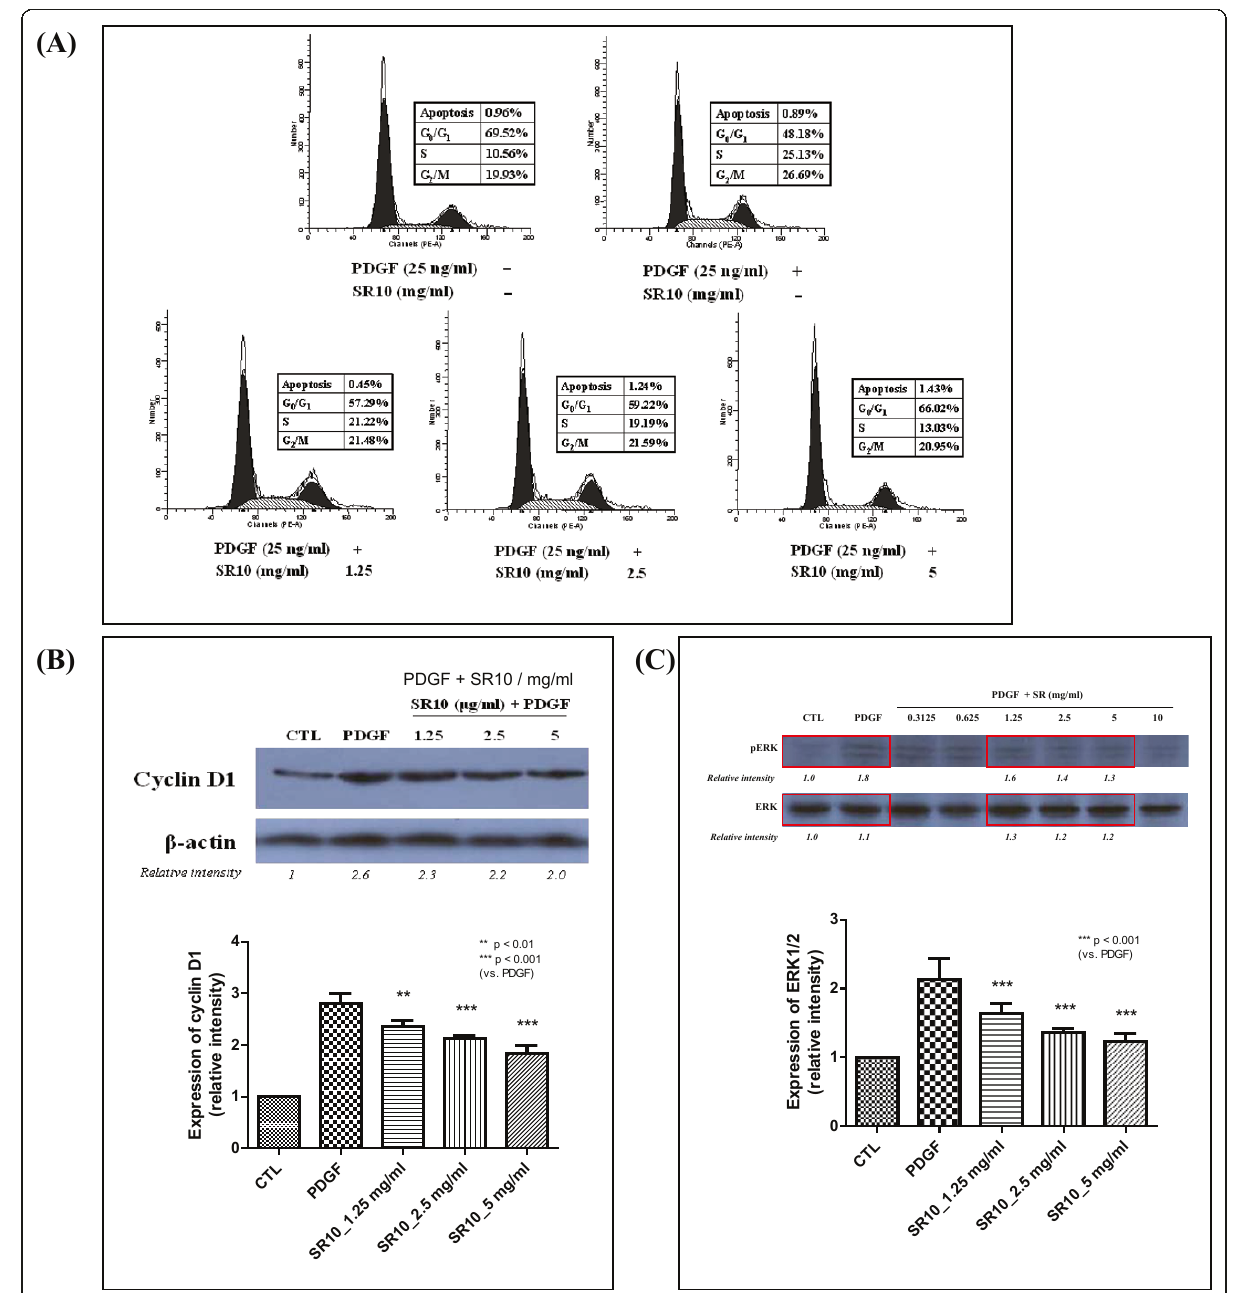
Figure 5 Effect of SR10 on cell cycle distribution of PDGF-BB-treated A7r5 cells . After starving with 1% fetal bovine serum for 24 hours, A7r5 cells were treated with PDGF-BB (25 ng/ml) in the absence or presence of SR10 for 24 hours. Then, the cells were stained with PI and cell cycle distribution was analyzed by flow cytometry. Three experiments were performed and similar results were observed. This figure showed the result of one representative experiment (A). The expression level of cyclin D1 was detected by Western blot. The figure is a representative of three independent experiments with similar results. The quantitation of cyclin D1 was performed by analyzing three sets of data by One-way ANOVA. Treatment of 1.25, 2.5 or 5 mg/ml of SR10 all suppressed the expression of cyclin D1 which was induced by PDGF. Statistical significance was indicated by ** p < 0.01 or *** p < 0.001 (B). The expression level of ERK1/2 was detected by Western blot. The figure is a representative of three independent experiments with similar results. The quantitation of ERK1/2 was performed by analyzing three sets of data by One-way ANOVA. Treatment of 1.25, 2.5 or 5 mg/ml of SR10 all suppressed the expression of cyclin D1 which was induced by PDGF (data shown in red boxes). Statistical significance was indicated by *** p < 0.001